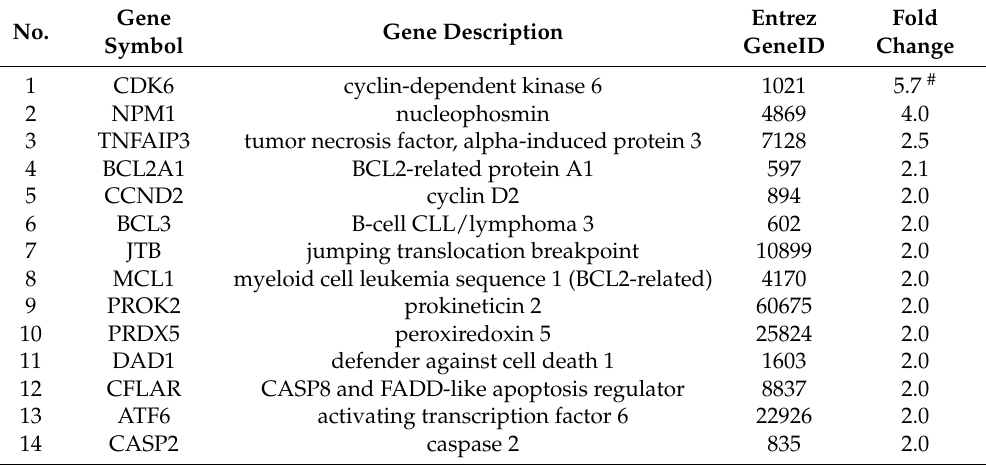
Table 3. The list of anti-apoptotic/pro-survival genes with the largest change of expression (at least 2 folds) in CD34+ cells from GHD patients treated for 6 months with GH-TS compared to GHD subjects before GH therapy.